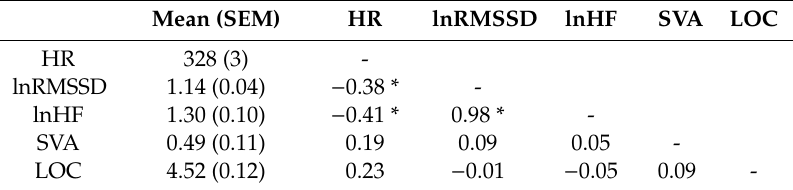
Table 1. Correlation matrix of 24-h cardiac autonomic and locomotor parameters in 42 wild-type Groningen rats.